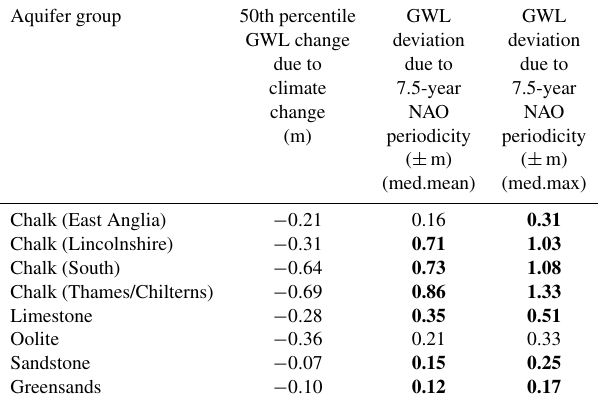
Table 1. Synthesis of Table 3 from Jackson et al. (2015). Median results from the absolute teleconnection modulation on groundwa- ter level from Fig. 3 of this paper are also presented for the mean and maximum modulation cases. NAO teleconnection modulations greater than the reported 50th percentile climate change modulation are in